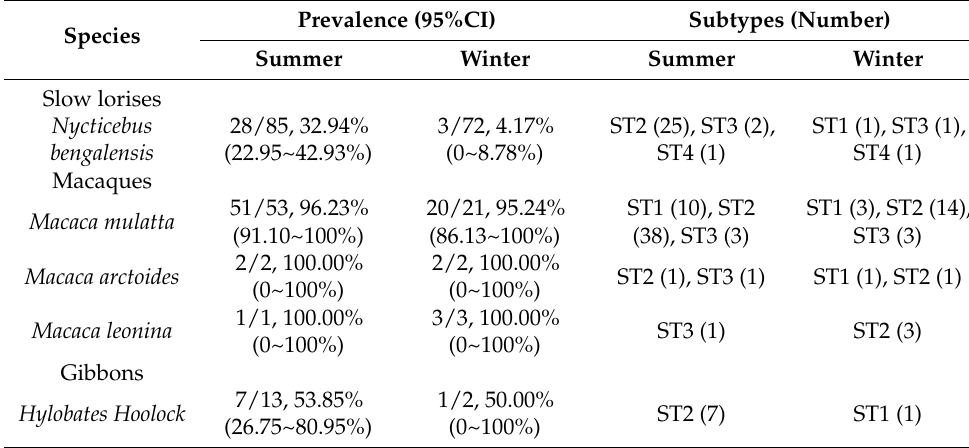
Table 2. Prevalence and subtype distribution of Blastocystis in NHPs.